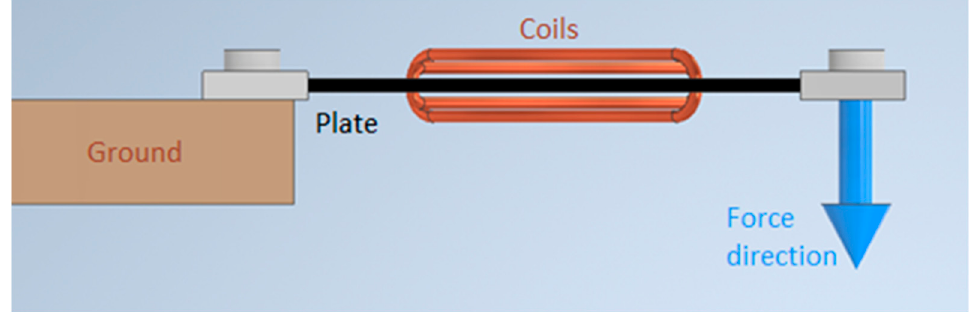
Figure 3. Plate loading scheme.